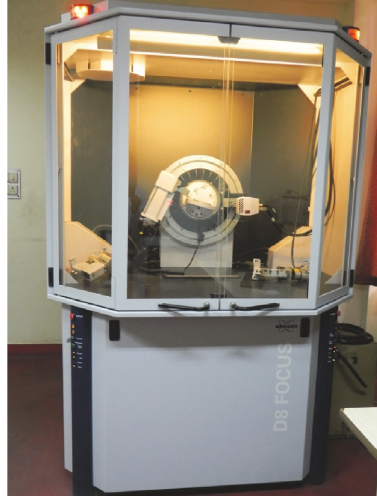
Figure 5: Bruker D8 ADVANCE powder X-ray diffractometer.